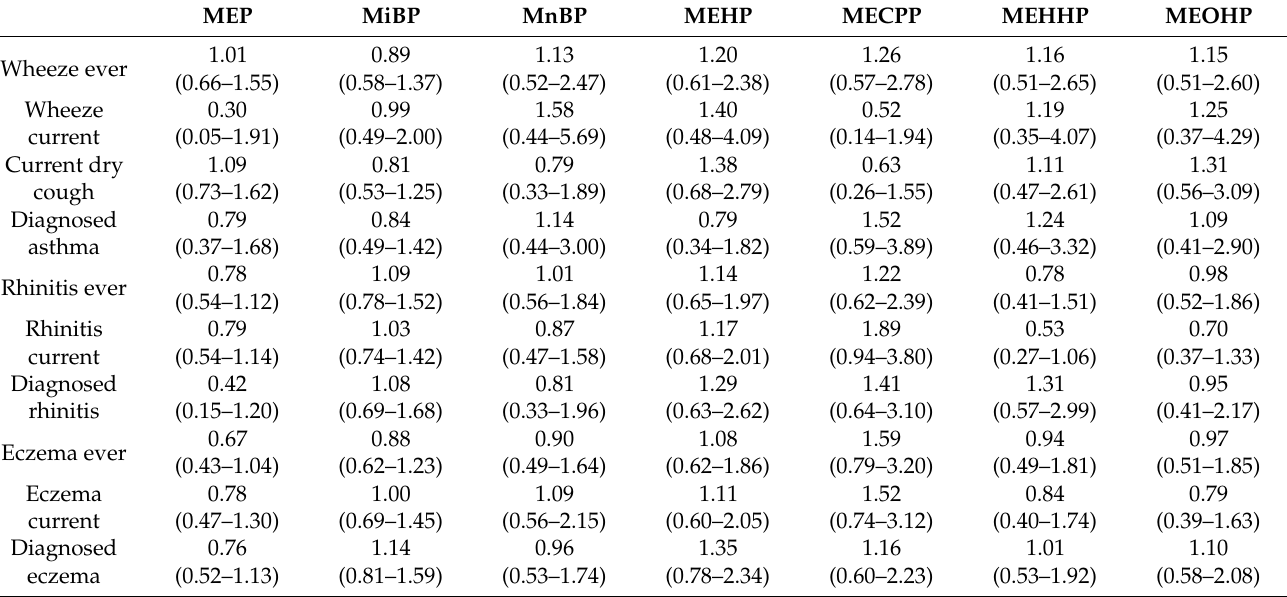
Table 6. Associations [AOR (95% CI)] between urinary phthalate metabolite concentrations and allergic symptoms in girls ( n =